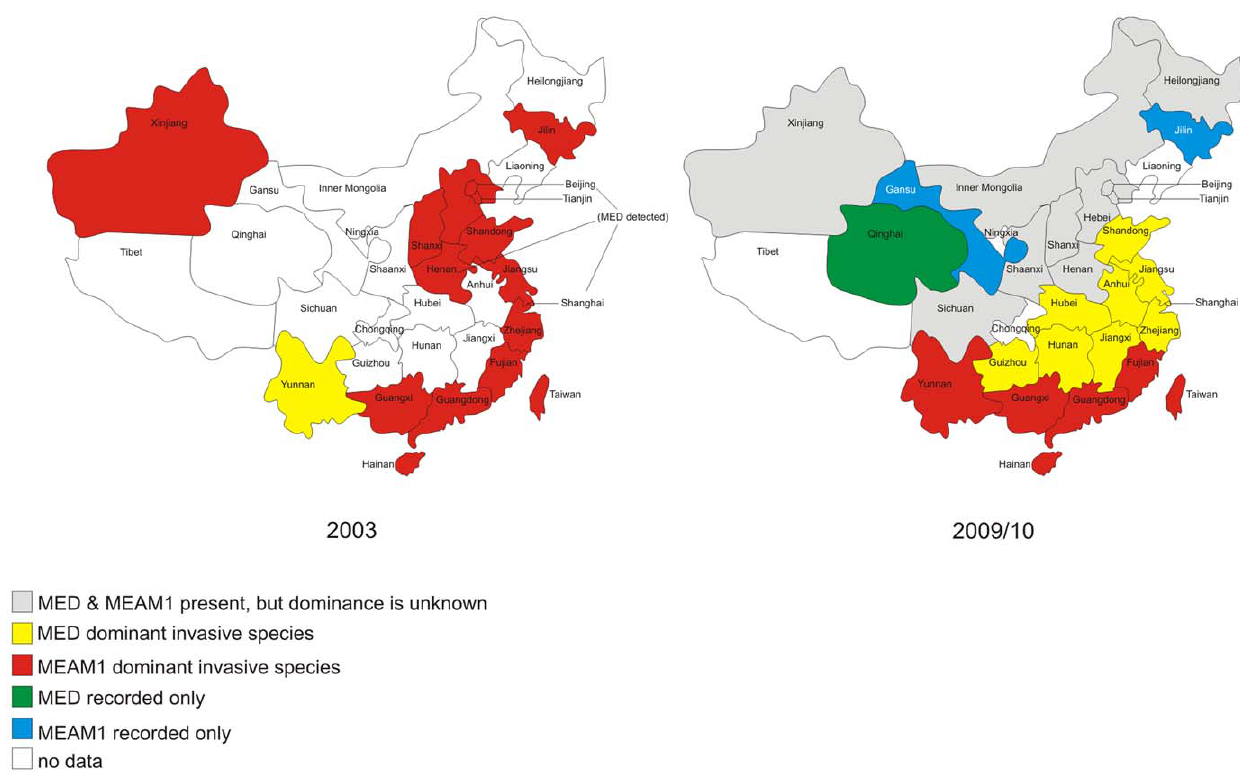
Figure 3. Distribution of the most frequently encountered invasive B.tabaci (MEAM1 and MED) in each province in China in 2003 and 2009/10. Data for the distributions in 2003 was obtained from Wu et al. [42], Chu et al. [26], Chu et al. [28] and Hsieh et al. [59]. The distributions for 2009/10 were either derived from this survey or from GenBank accessions.